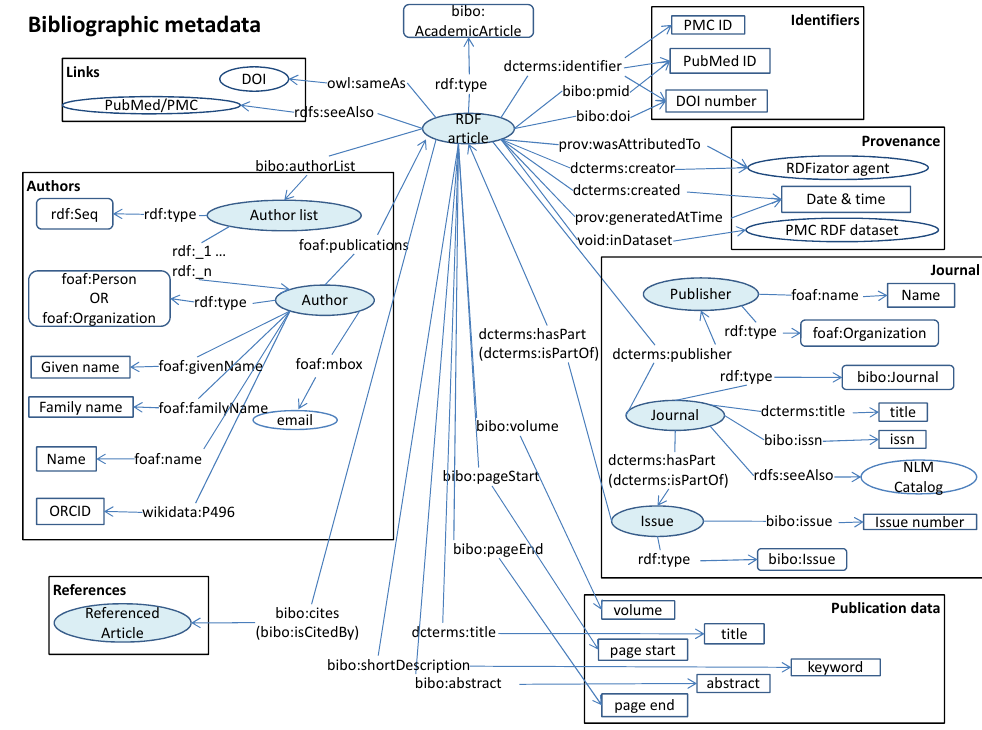
Figure 2. Model used for describing article metadata, including authors, references, identifiers and journal information. Core concepts in the model are marked in blue. Adapted from